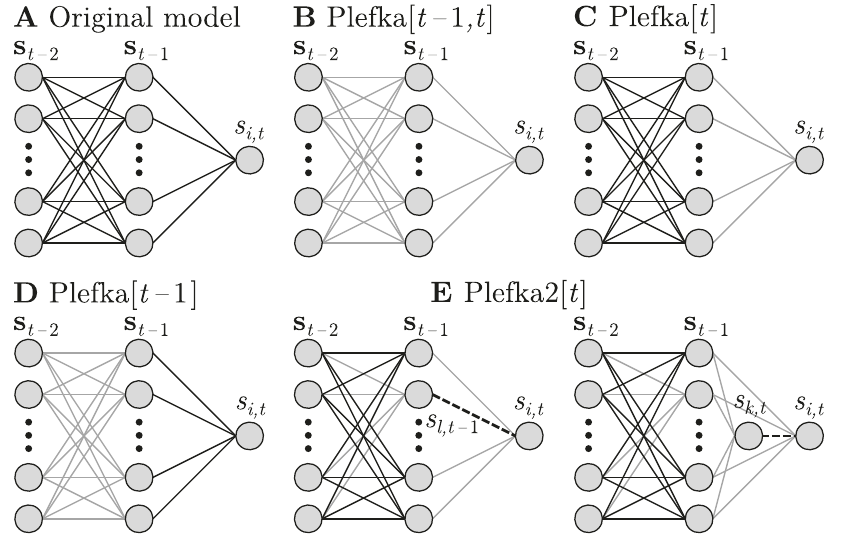
Fig. 2 Uni fi ed mean- fi eld framework. Original model ( A ) and family of generalized Plefka expansions ( B – E ). Gray lines represent connections that are proportional to α and thus removed in the approximated model to perform the Plefka expansions, while solid black lines are conserved and dashed lines are free parameters. Plefka[ t − 1, t ] ( B ) retrieves the classical naive and TAP mean- fi eld equations 38,39 . Plefka[ t ] ( C ) results in a novel method which preserves correlations of the system at t − 1, incorporating equations similar to ref. 40 . Plefka[ t − 1] ( D ) assumes independent activity at t-1, and in its fi rst order approximation reproduces the results in ref. 41 . Plefka2[ t ] ( E ) represents a novel pairwise approximation which performs better in approximating